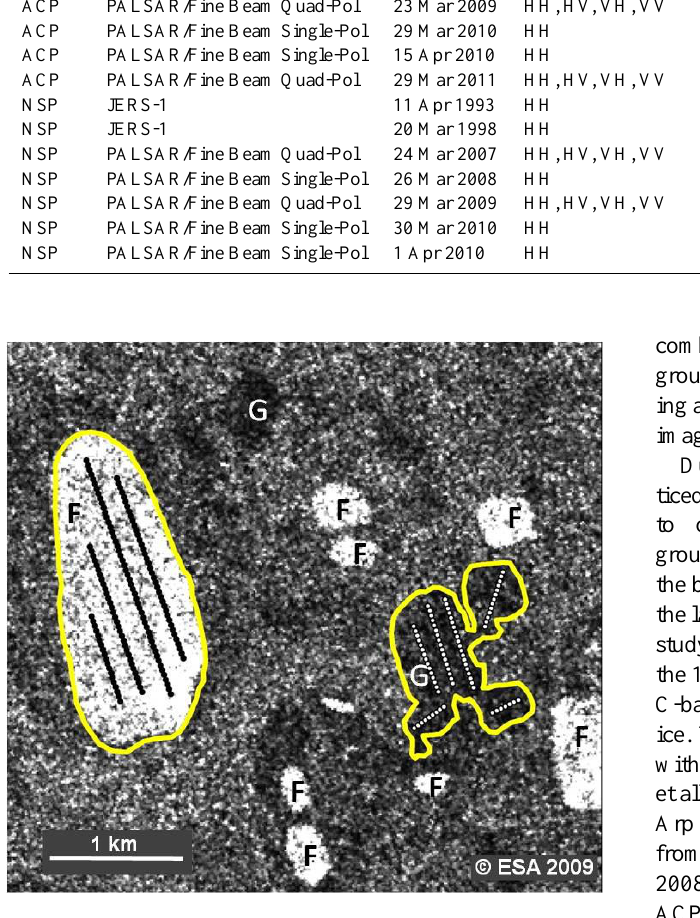
Figure 2: C-band VV SAR image of thermokarst lakes on the Arctic Coastal Plain (ACP), Alaska. High backscatter from floating lake ice is indicated by “F” while low backscatter from grounded lake ice is indicated by “G”. Two study lakes are outlined in yellow and pixel sampling locations are rows of uniformly spaced points, shown in contrasting color.